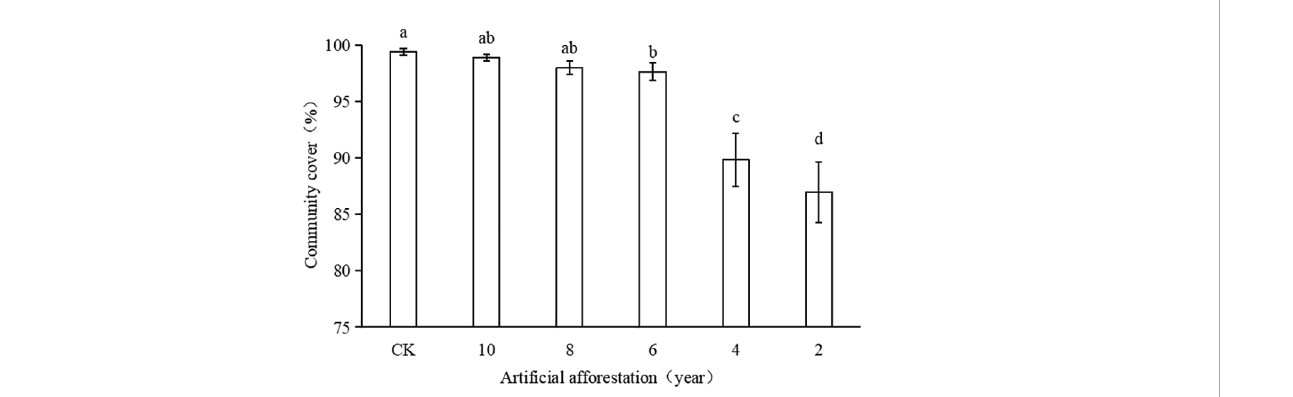
FIGURE 2 Coverage of grassland plant communities with different arti fi cial afforestation years in Maxian Mountain of the Loess Plateau. Different lowercase letters indicate statistically signi fi cant differences in coverage of grassland plant communities between arti fi cial afforestation years by LSD test (p<